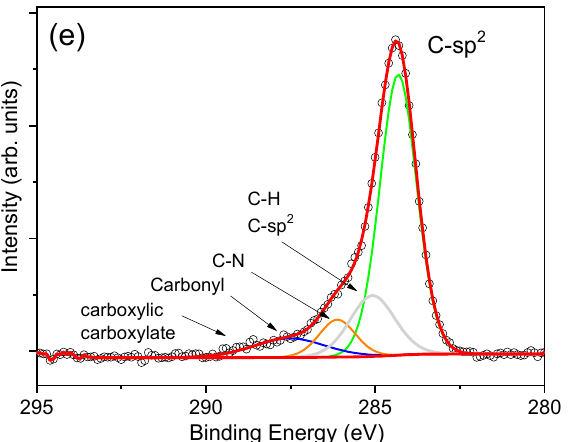
Figure 4. X-ray photoelectron spectroscopy (XPS) spectra of as-grown MoS 2 -cyst film: ( a ): survey, ( b ): Mo3d, ( c ): S 2p, ( d ): Mo 3p), and ( e ): C1s.